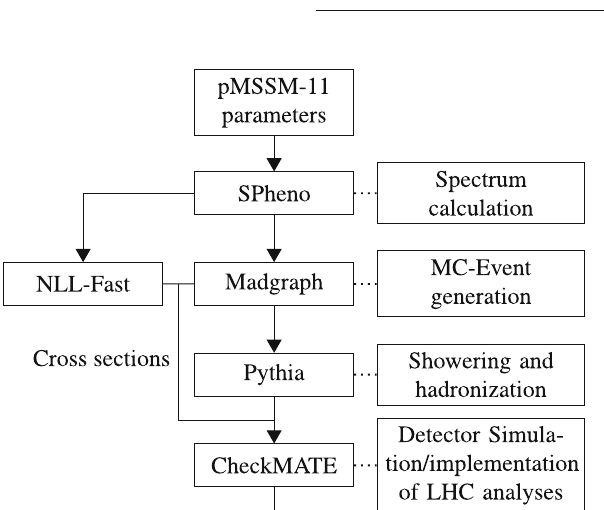
Table 1 pMSSM-11 ranges we have used for the sample generation. The lower bounds on the mass parameters were motivated by the current collider bounds for SUSY particle production. The relatively large range for third generation trilinear coupling A were motivated by the observed Higgs mass. All the pMSSM-11 parameters were defined at a scale of 1 TeV [18]